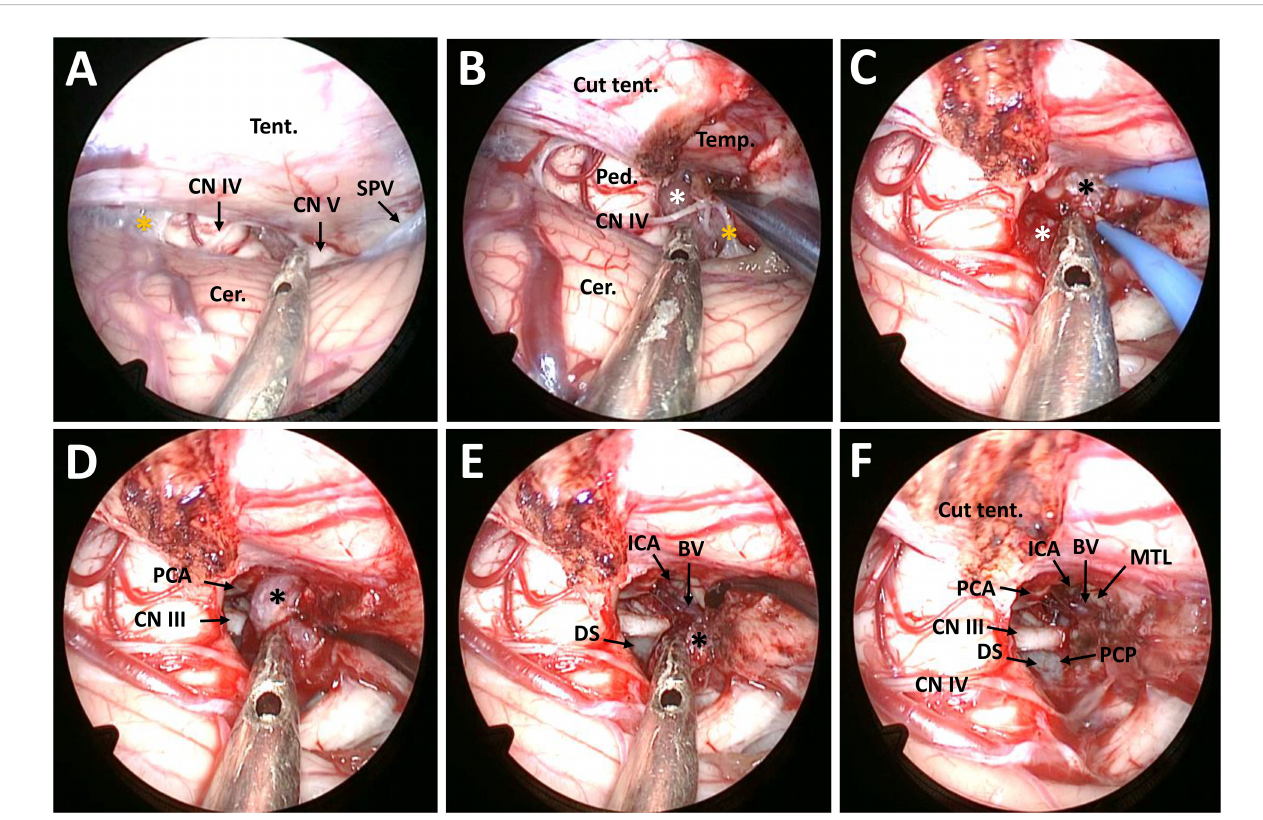
FIGURE 2 Surgical procedure and nuances of the EF-SCITA approach for resection of posterior clinoid meningioma. (A) Endoscopic explorations in the lateral supracerebellar infratentorial space and the exposure of CN IV after opening the arachnoid in the ambient cistern. (B) The exposure of the infratentorial part of the tumor in the ambient cistern after incision of the tentorium cerebelli. (C) The exposure of the supratentorial tumor after up-elevating the tentorium cerebelli. (D) The exposure of the PCA and CN III as well as the supratentorial tumor after debulking of the infratentorial tumor. (E) Dissection of the supratentorial tumor from the ICA and the initial part of BV and the exposure of DS during tumor resection. (F) The exposure of PCP after total tumor removal. BV, basal vein of Rosenthal (the initial part); Cer., cerebellum; CN III, oculomotor nerve; CN IV, trochlear nerve; CN V, trigeminal nerve; DS, dorsum sellae; ICA, internal carotid artery; MTL, medial temporal lobe; PCA, posterior cerebral artery; PCP, posterior clinoid process; Ped., pedunculus cerebri; PS, pituitary stalk; SPV, superior petrosal vein; Tent., tentorium cerebelli. The black asterisks indicate the supratentorial part of the tumor, the white asterisk denotes the infratentorial part of the tumor, and the yellow asterisks indicate the arachnoid in the ambient